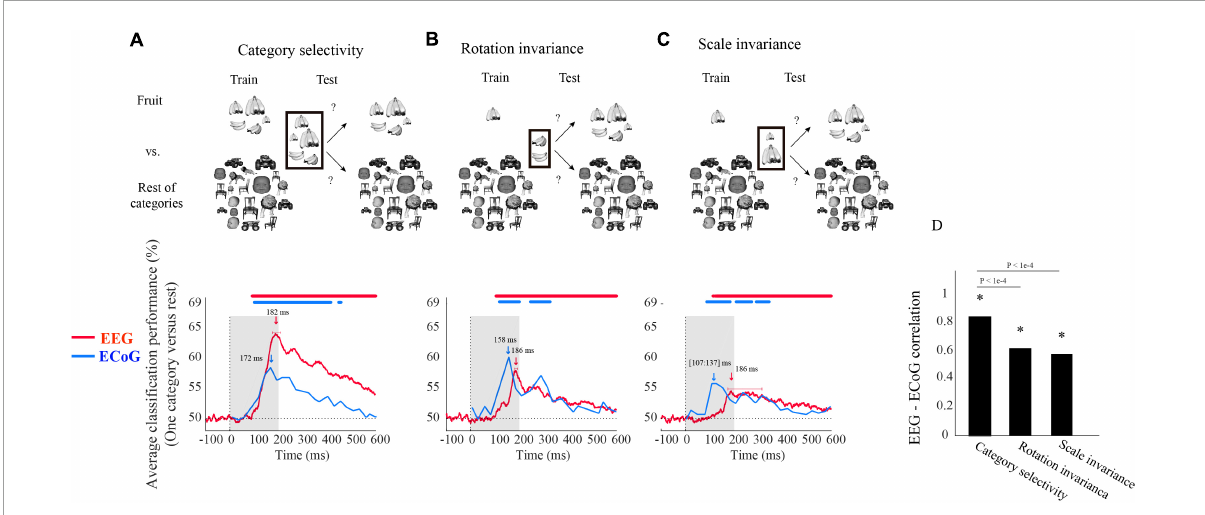
FIGURE1 Electroencephalogram and ECoG average classification performance (one category vs. rest) assessing (A) category selectivity, (B) rotation invariance, and (C) scale invariance over time. The sketches in the top row visualize the rationale of the three classification schemes (i.e., determining category selectivity, rotation invariance, and scale invariance) by showing example images for data entering the classifications. The bottom row shows the classification results. The red curves show EEG classification performance averaged over five categories and participants ( N = 21). The blue curves show the mean ECoG classification performance over 5 categories using 11 selective electrodes and IFP (intracranial field potential) power in bins of 25 ms. The horizontal lines above the curves indicate significant time points [EEG: bootstrap test of 21 participants with 10,000 repetitions, FDR-corrected at p < 0.05; ECoG: as in the Liu et al. (2009), i.e., permutation test over stimuli, not corrected, for details on peak latency comparison, see Supplementary Table 1 ]. (D) Correlation between EEG and ECoG classification time courses. Stars show significance, and the values above the bar charts indicate the p -values of the differences between the correlation coefficients (bootstrap test of 21 participants with 10,000 repetitions, for more details, see Supplementary Table 2